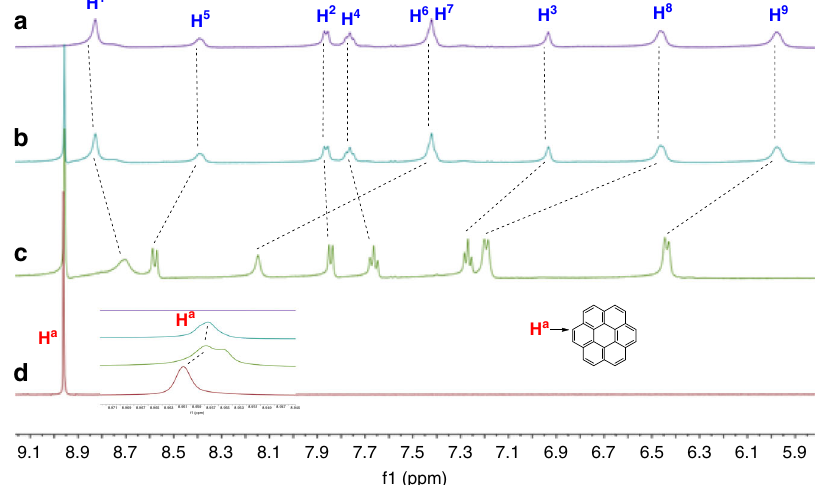
Fig. 4 Partial 1 H NMR (500 MHz, THF- d 8 , 25 °C) spectra of 5 , 5 2 (cid:129) 7 , and 7 . a 1 H NMR spectrum of 5 . b 1 H NMR spectrum of 5 2 (cid:129) 7 . c 1 H NMR spectrum of a mixture of 5 2 (cid:129) 7 and n -Bu 4 NCl. d 1 H NMR spectrum of